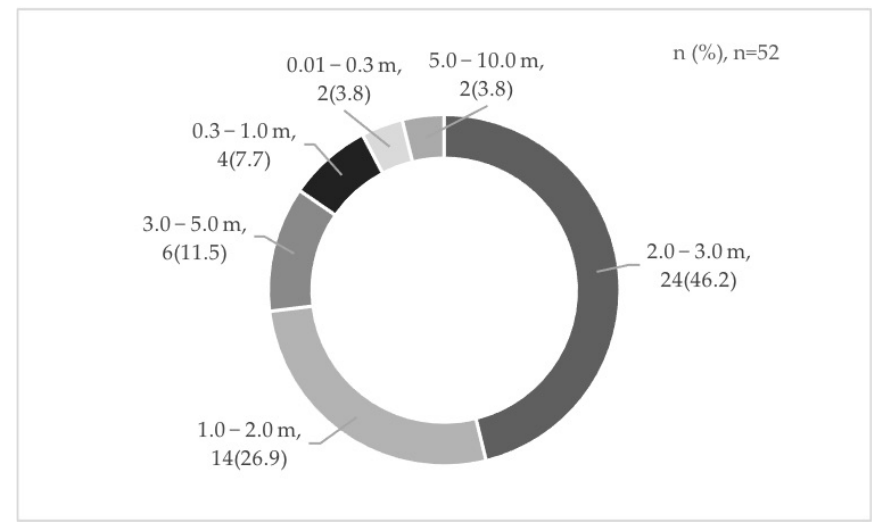
Figure 4. Number and percentage of childcare centers by inundation depth.